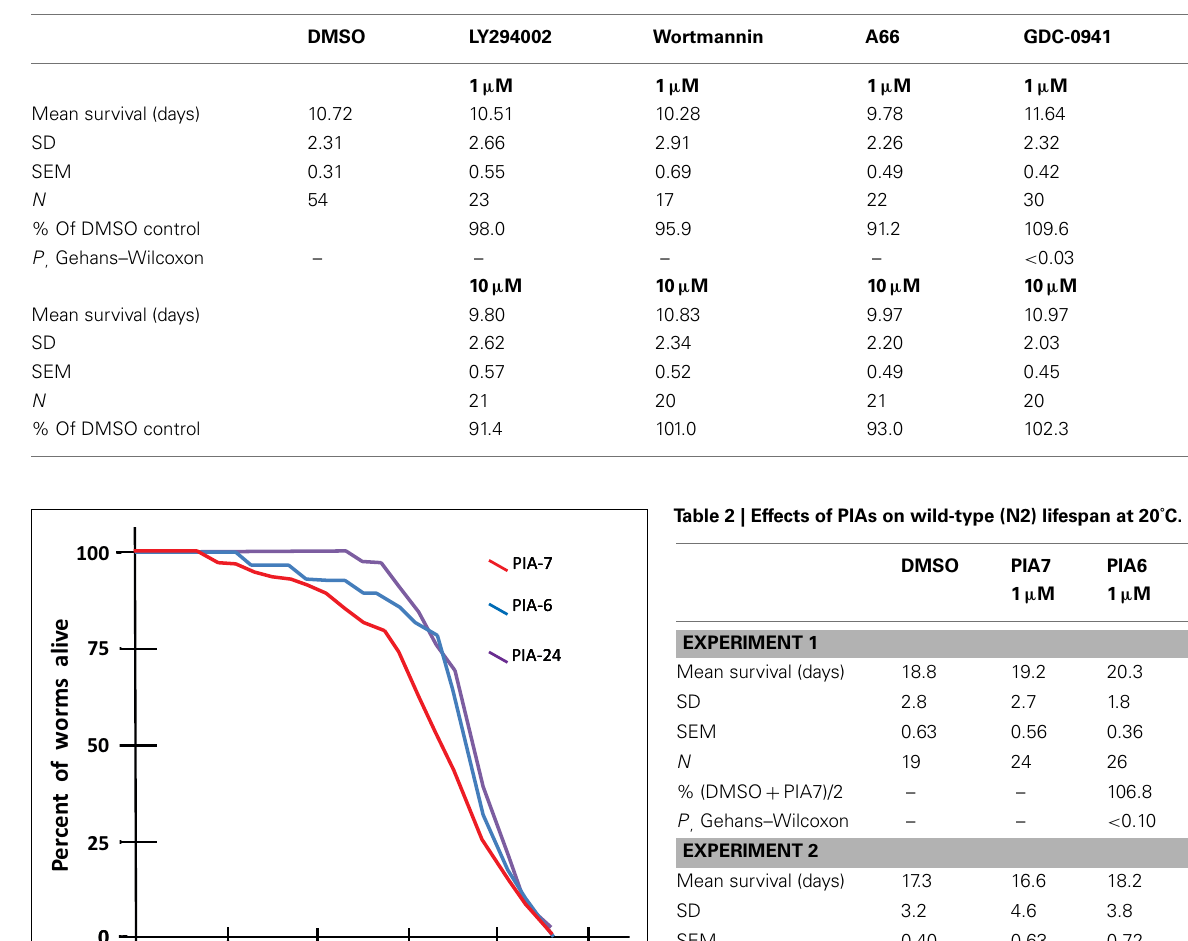
Table 1 | Effects of PI3K inhibitors on wild-type lifespan at 25˚C.